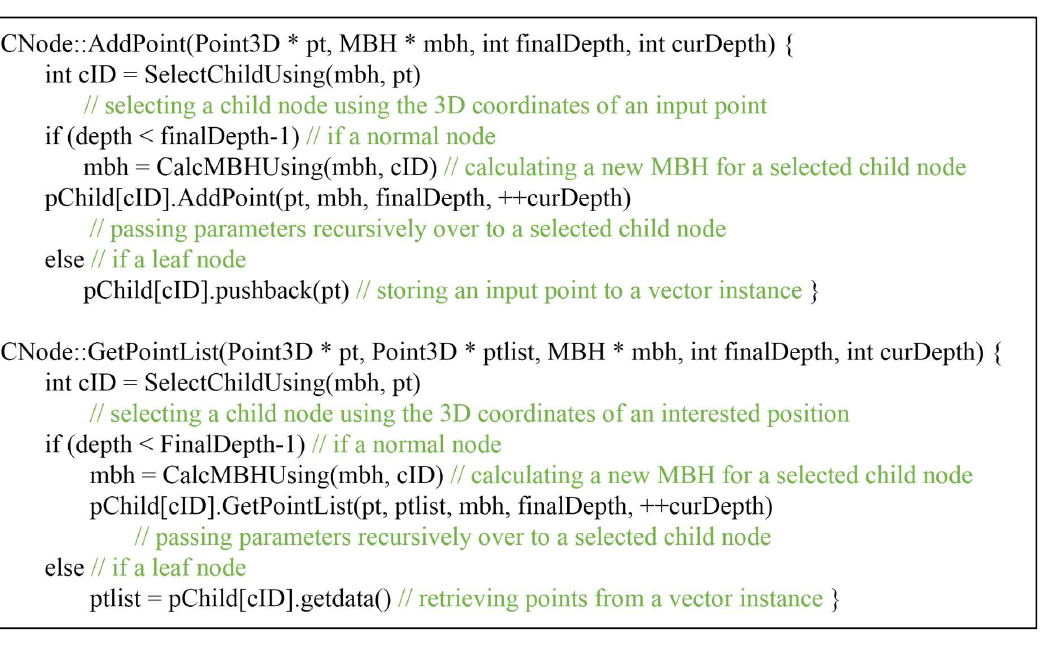
Figure 3. Pseudo codes of the AddPoint and GetPointList methods.